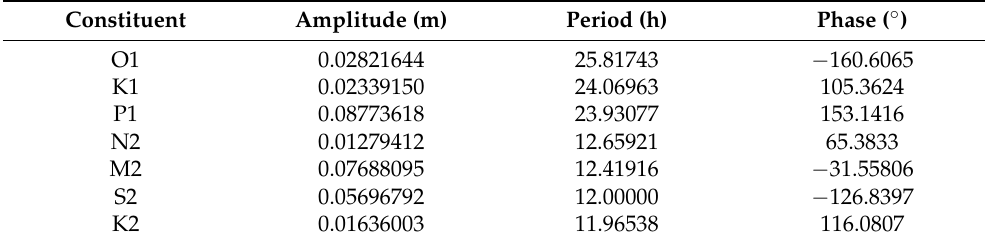
Table 1. Tidal constituents with corresponding values of amplitude, period and phase. Constituent